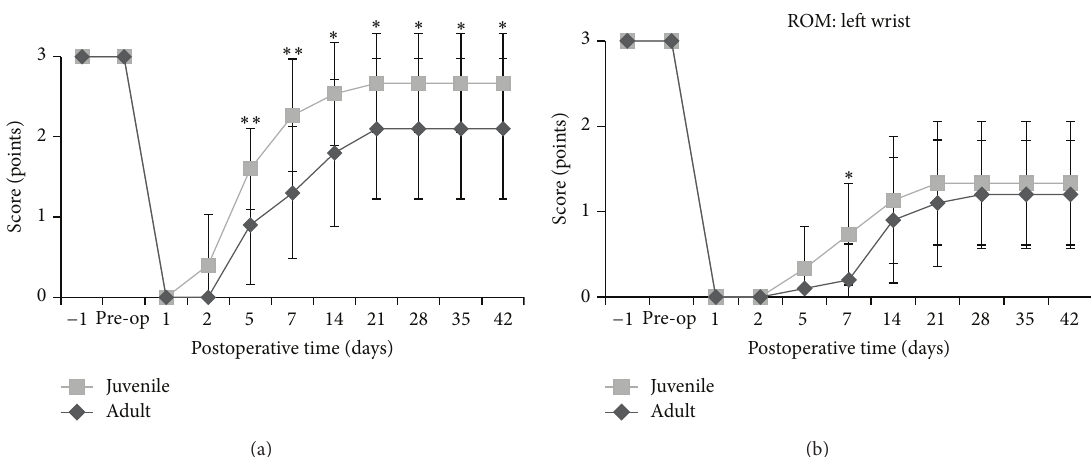
Figure 8: Range of motion (ROM) scores in juvenile and adult rats. The ROM of the left elbow shows that juvenile rats recovered significantly more than adult rats. The ROM score of the left wrist shows no significant difference between juvenile and adult rats ( ∗ 𝑃 < 0.05 ; ∗∗ 𝑃 < 0.01 ).